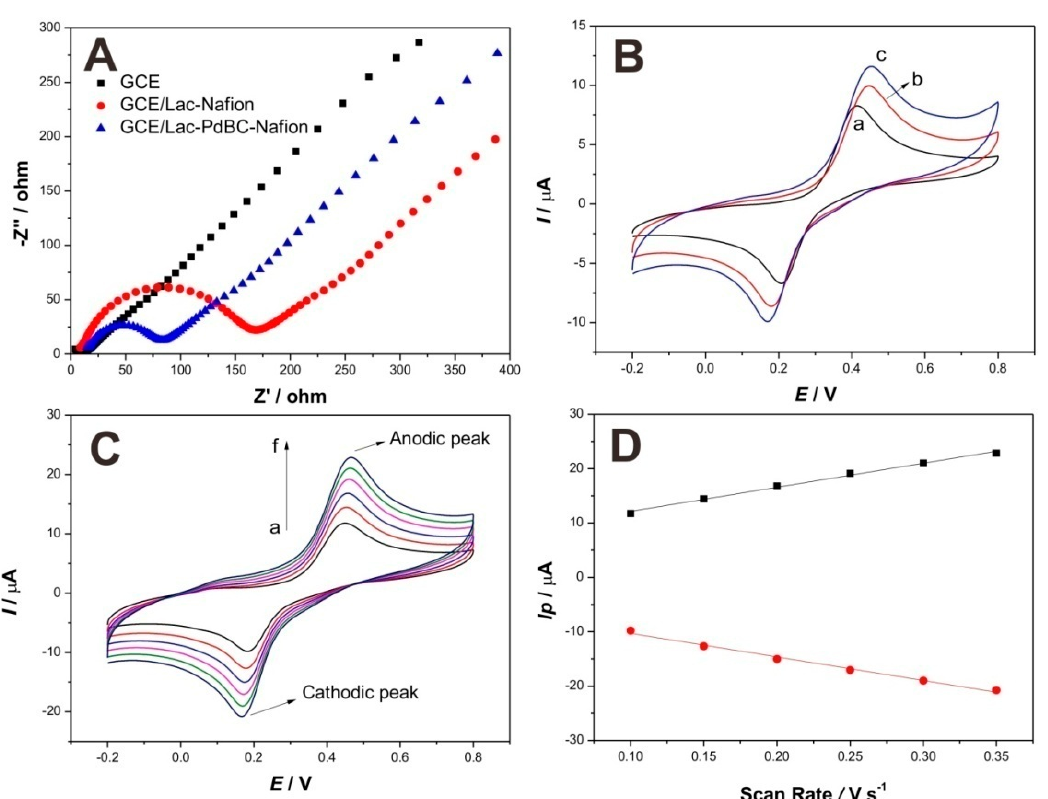
Figure 5. Electrochemical Impedance Spectroscopy (EIS) of modified electrodes: bare GCE, GCE/Lac-Nafion, and GCE/Lac-PdBC-Nafion in 0.1 M KCl containing 5 mM Fe(CN) 63 − /4 − . Frequency range: 0.01 Hz–100,000 Hz. Amplitude: 5 mV ( A ); Cyclic voltammograms of: (a) bare GCE; (b) GCE/Lac-Nafion; and (c) GCE/Lac-PdBC-Nafion in pH 7.0 PBS containing 100 µM dopamine at 100 mV·s − 1 ( B );Cyclic voltammograms of GCE/Lac-PdBC-Nafion in pH 7.0 PBS containing 100 µM dopamine at scan rates of 100, 150, 200, 250, 300, and 350 mV·s − 1 (a–f), respectively ( C );Plots of the corresponding anodic and cathodic peak currents vs. scan rate ( D ).